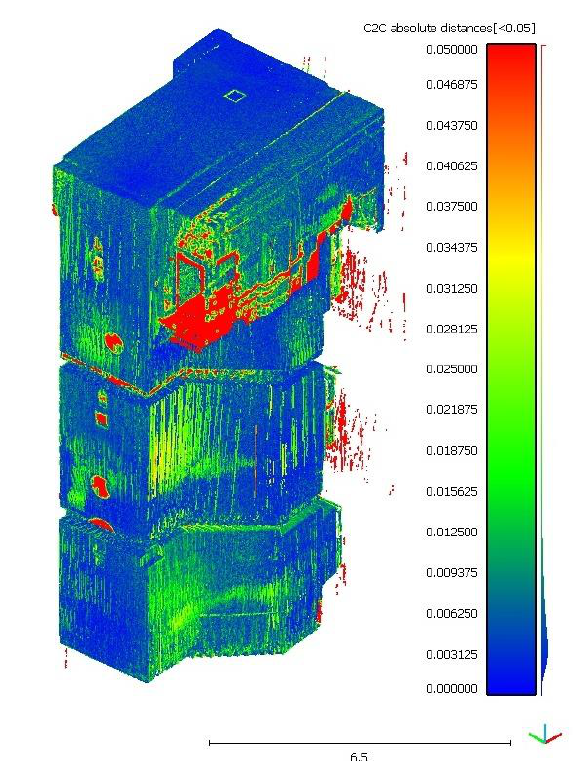
Figure 4 . Cloud-to-cloud comparison on point cloud of stairs at the test object n.